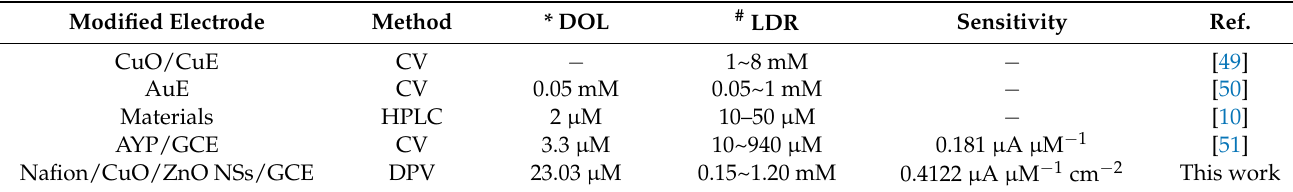
Table 1. The comparison of analytical performances of TU sensors based on various nanomaterial sensor probe by electrochemical